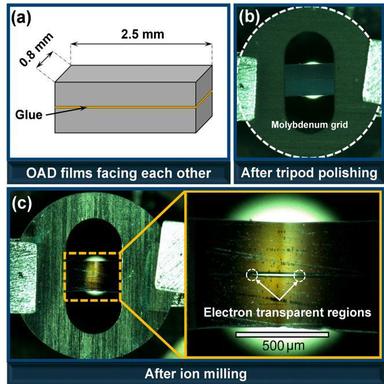
Different stages involved in preparing delicate TEM specimens using the tripod method. (a) Scheme of a glued staked specimen before polishing. Pictures of the specimen, once attached to a 3 mm TEM molybdenum grid, after tripod polishing (b) and after ion milling (c). The inset of (c) places emphasis on the developed electron-transparent region.